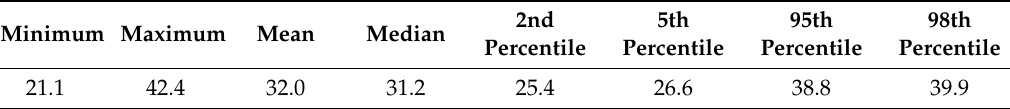
Table 2. Causes of death at Vadu HDSS, 2003–2012.